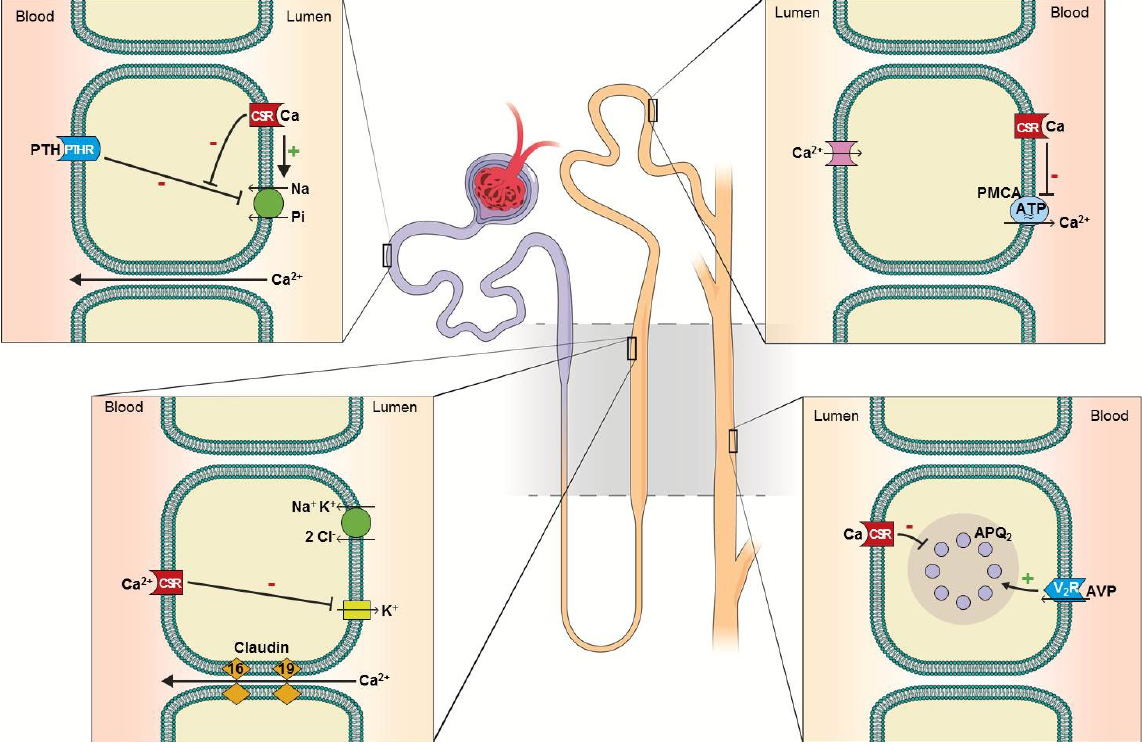
Figure 1. Calcium reabsorption and calcium-sensing receptor in the nephron. ( A )